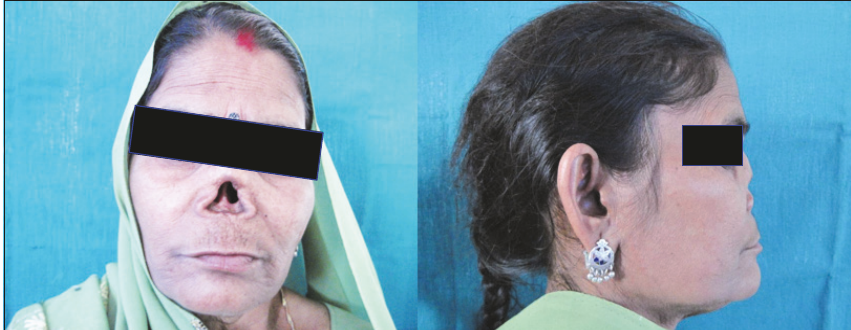
Figure 1: Patient’s face with large size nasal defect (frontal and profile